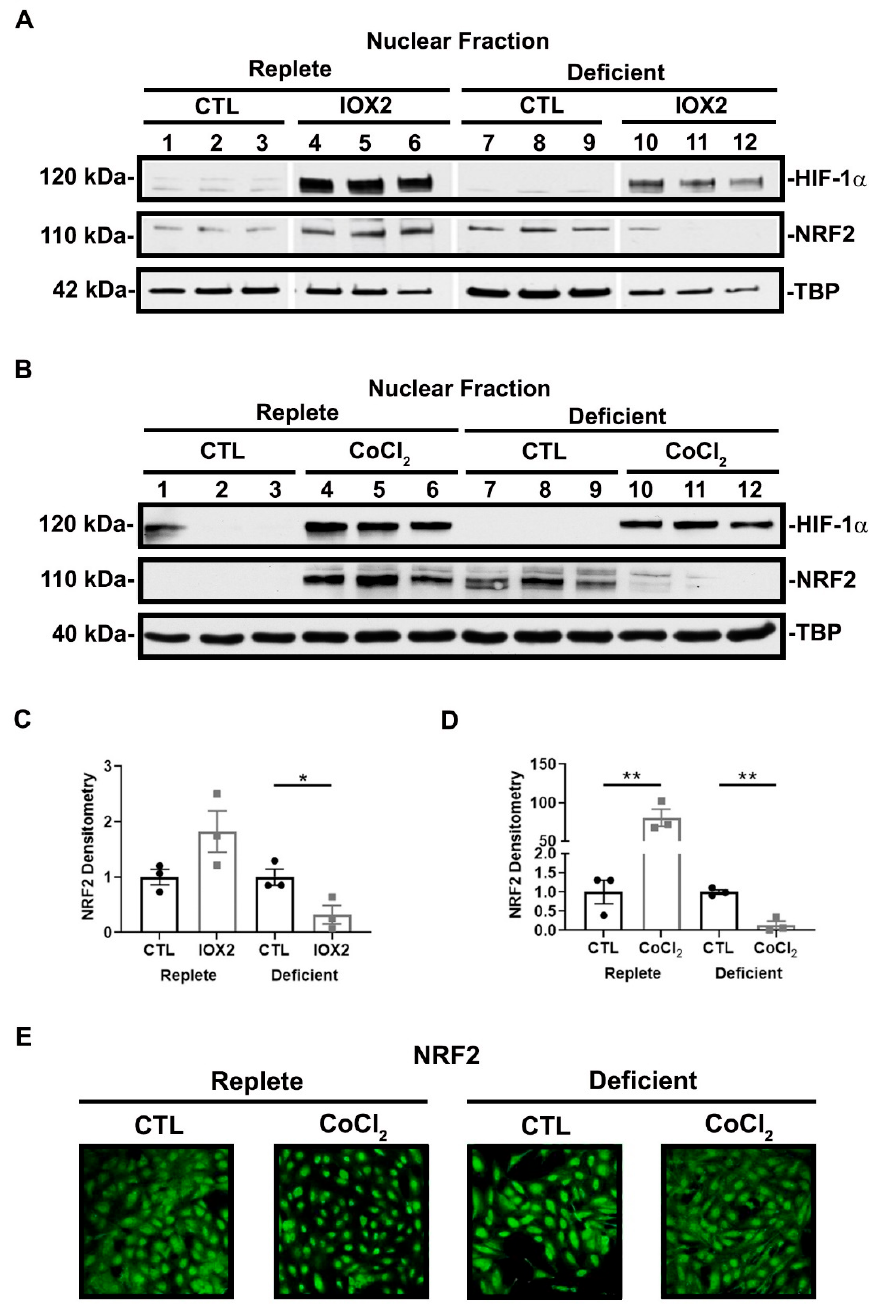
Figure 6. NRF2 nuclear localization is responsive to HIF-1 α activation and nutrient availability. ( A , B ) Representative immunoblots of HIF-1 α and NRF2 nuclear localization after 16 h exposure to nutrient-replete or nutrient-deficient conditions in the presence or absence of 50 µ M IOX2 or 200 µ M CoCl 2 . IOX2 and CoCl 2 increase HIF-1 α nuclear localization regardless of nutrient condition. In replete conditions, IOX2- and CoCl 2 -mediated HIF-1 α activation increase NRF2 in the nuclear fraction of the cell lysates. Deficient conditions alone increase NRF2 nuclear localization but is suppressed in the presence of IOX2- and CoCl 2 -mediated HIF-1 α activation. ( C , D ) Densitometry of NRF2 normalized to TBP. Bars are mean ± S.E.M. Unpaired Student’s t -test. * p < 0.05 and ** p < 0.01. ( E ) Representative immunofluorescent images of NRF2 protein expression after 16 h exposure to nutrient-replete or nutrient-deficient conditions in the presence or absence of 200 µ M CoCl 2 . In replete conditions, NRF2 nuclear localization increases with CoCl 2 -mediated HIF-1 α activation. However, in deficient conditions, CoCl 2 -mediated HIF-1 α activation suppresses NRF2 nuclear